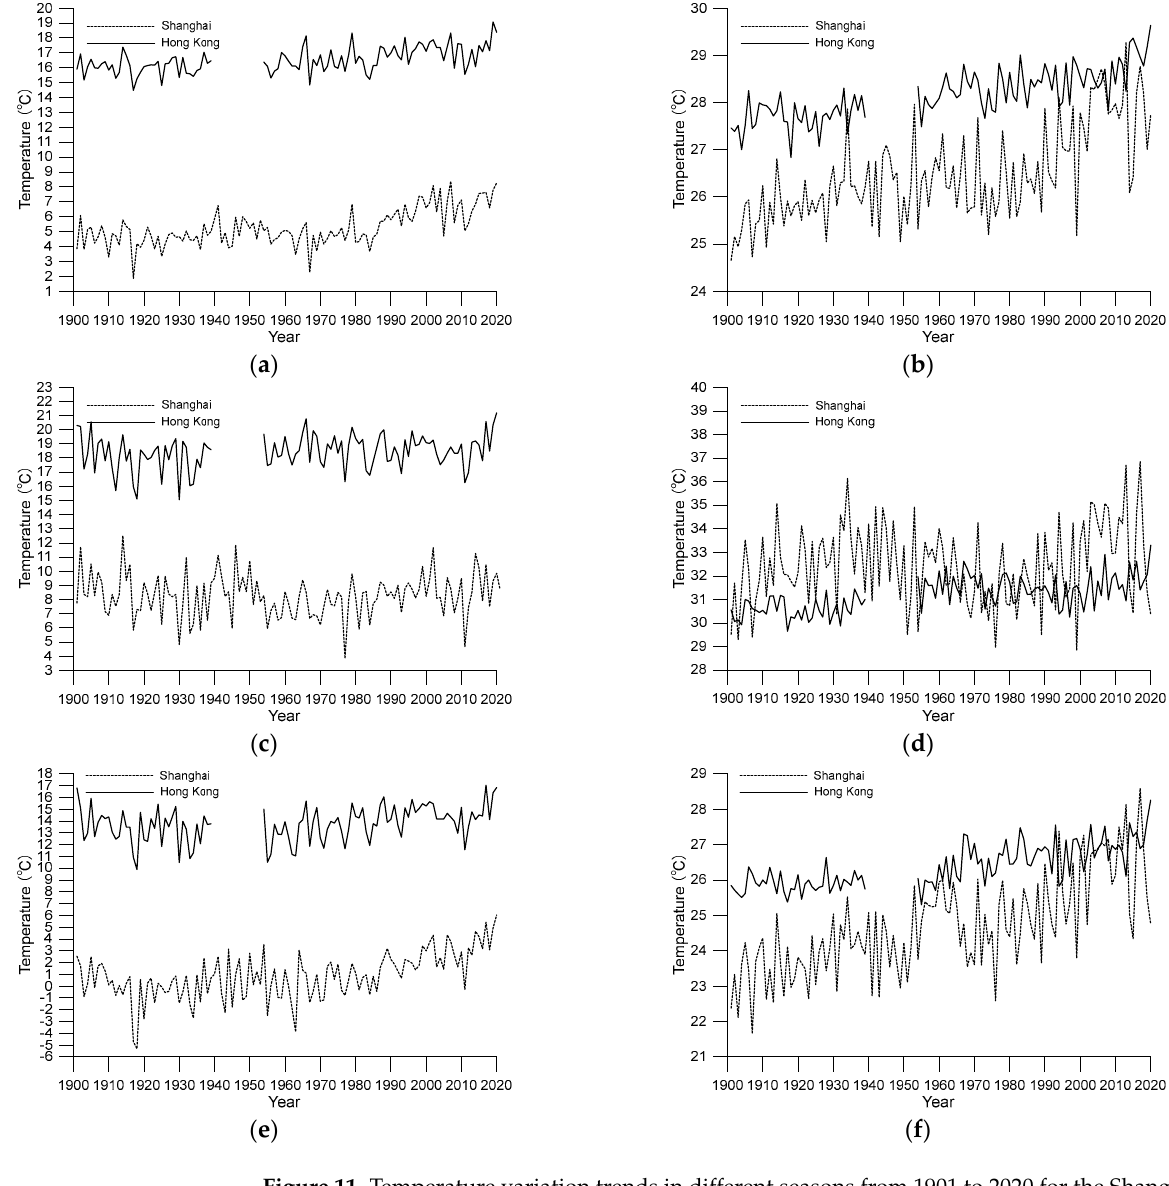
Figure 11. Temperature variation trends in different seasons from 1901 to 2020 for the Shanghai and Hong Kong observatories (( a ) the average temperature in winter; ( b ) the average temperature in summer; ( c ) the maximum temperature in January; ( d ) the maximum temperature in July; ( e ) the minimum temperature in January; ( f ) the minimum temperature in July).